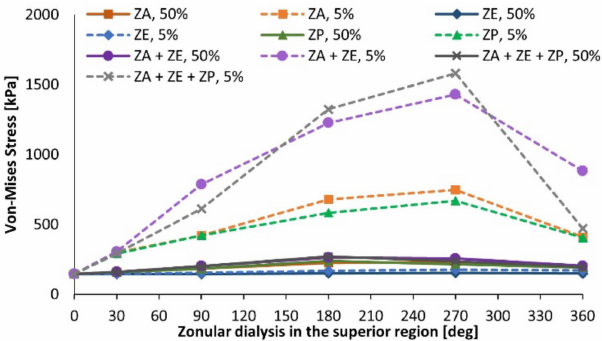
Figure 5. Maximum Von-Mises stress in the zonules for models with superior